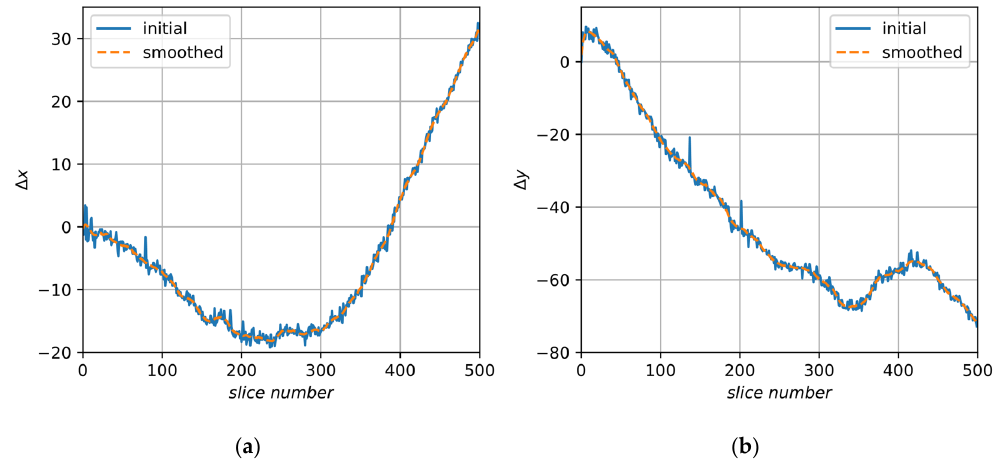
Figure 9. Initial and smoothed elements of decomposition for sample A: ( a ) displacement along the X axis, ∆𝑥 ; ( b ) displacement along the Y axis, ∆𝑦 .